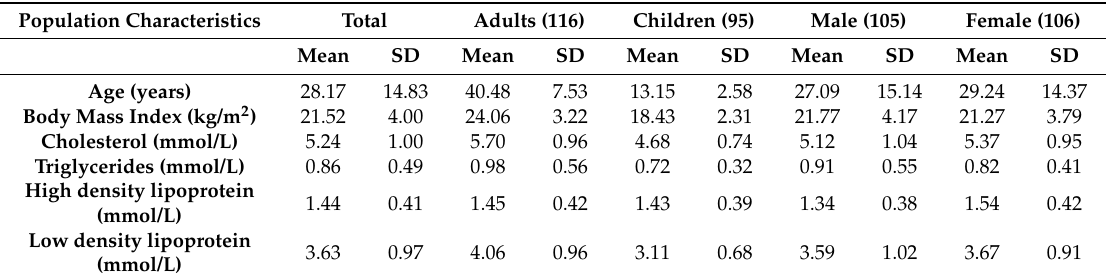
Table 3. Populations characteristics of discovery